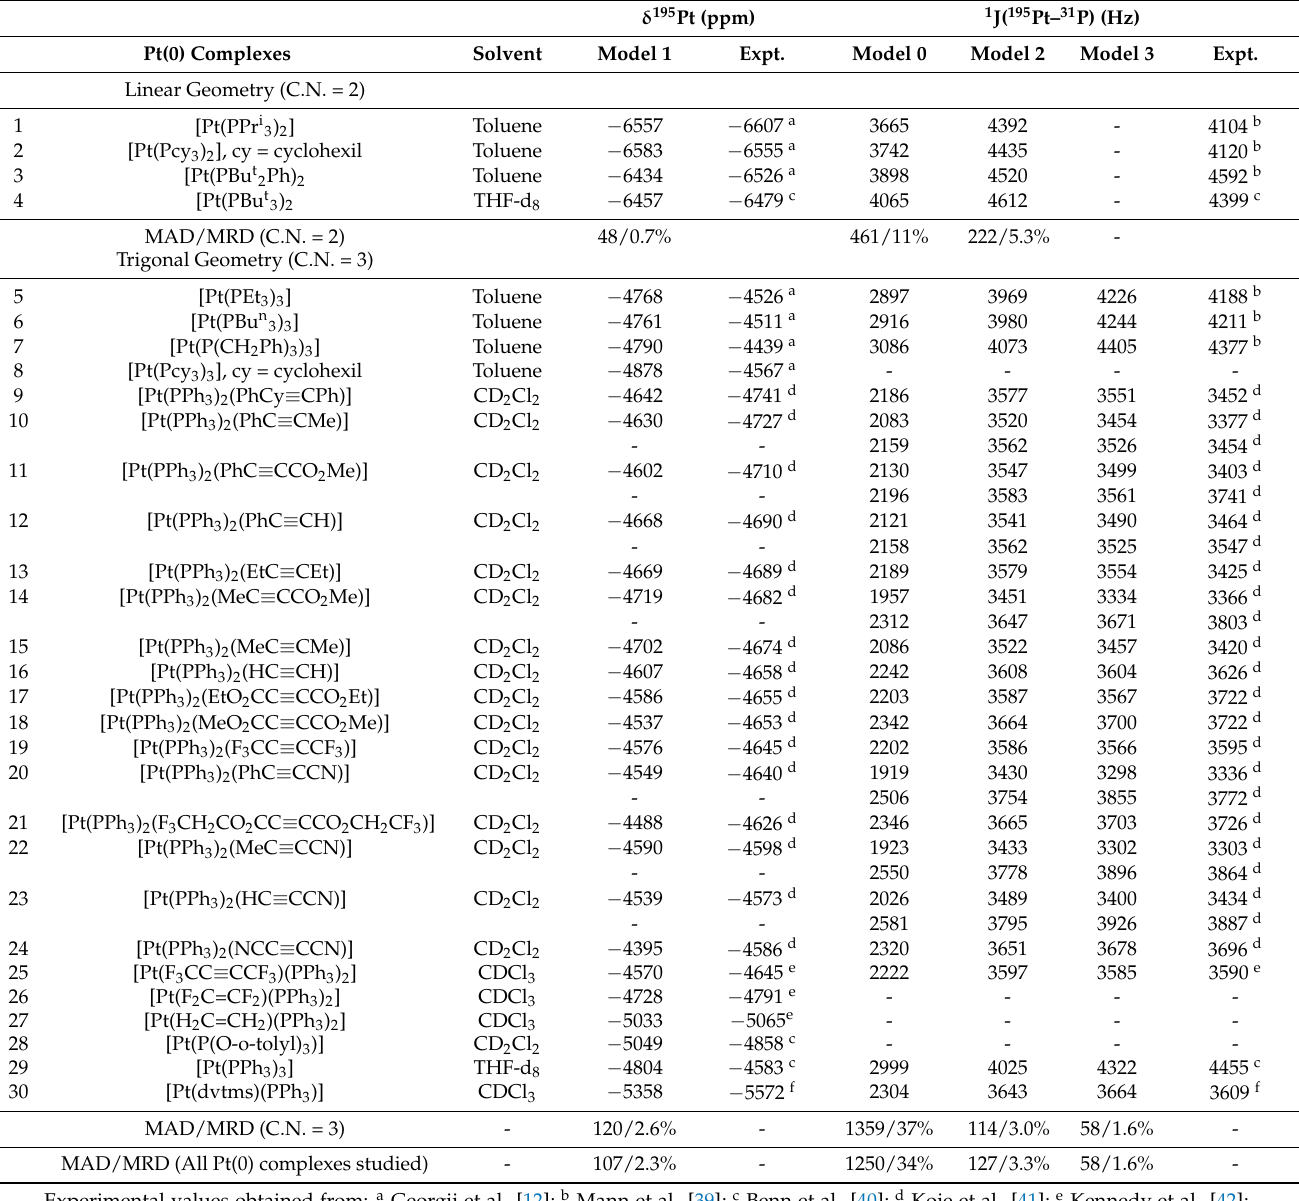
Table 2 shows the predicted Pt-195 NMR chemical shift using Model 1 for the 30 Pt(0) complexes. Considering all the complexes, the MAD and MRD were 107 ppm and 2.3%, respectively, showing that Model 1 has satisfactory predictive power. When the complexes with C.N. 2 and 3 are evaluated separately, the MAD and the MRD are 48 ppm and 0.7% (four linear complexes with C.N. 2), and 120 ppm and 2.6% (25 trigonal complexes with C.N. 3). Table 2. Calculated δ 195 Pt, in ppm, and 1 J( 195 Pt– 31 P), in Hz, for the Pt(0) complexes used in the construction of the proposed empirical